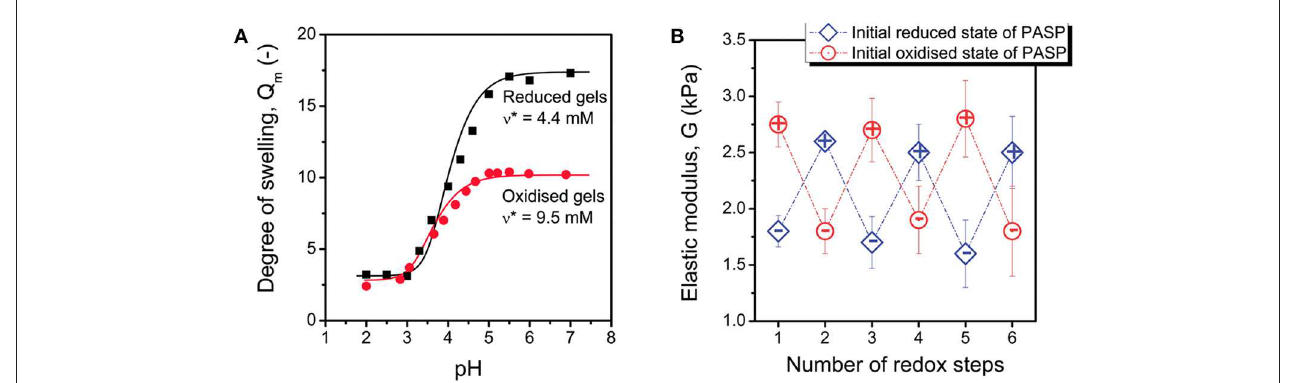
FIGURE 2 | PASP hydrogels based on disulfide bonds. (A) Swelling of PASP hydrogels cross-linked with cysteamine in reduced and oxidized states as a function of pH shows conventional behavior of anionic hydrogels, swelling under reduced condition is higher. (B) Elastic modulus of the corresponding hydrogels shows reversible increase and decrease upon oxidation/reduction. Reproduced from Gyarmati et al. (2014) with permission from The Royal Society of